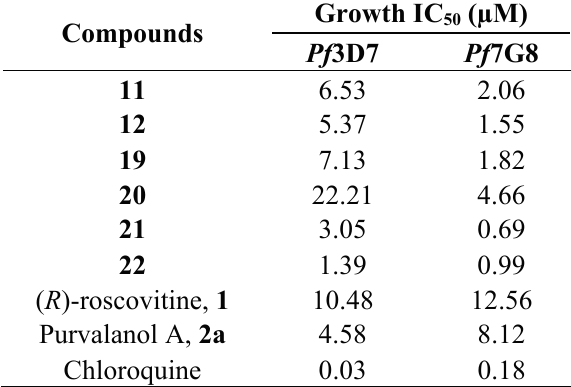
measurement. Compounds with IC 50 > 6 µM on Pf 3D7 are drawn with light grey background. The most potent P. falciparum growth inhibitors are drawn with dark grey background. Table 2. IC 50 values for Pf 3D7 and Pf 7G8 for the six mammalian kinase inhibitors and the three control molecules. These values were estimated by non-linear regression analysis using an inhibitory sigmoid E max model. All assays were run in